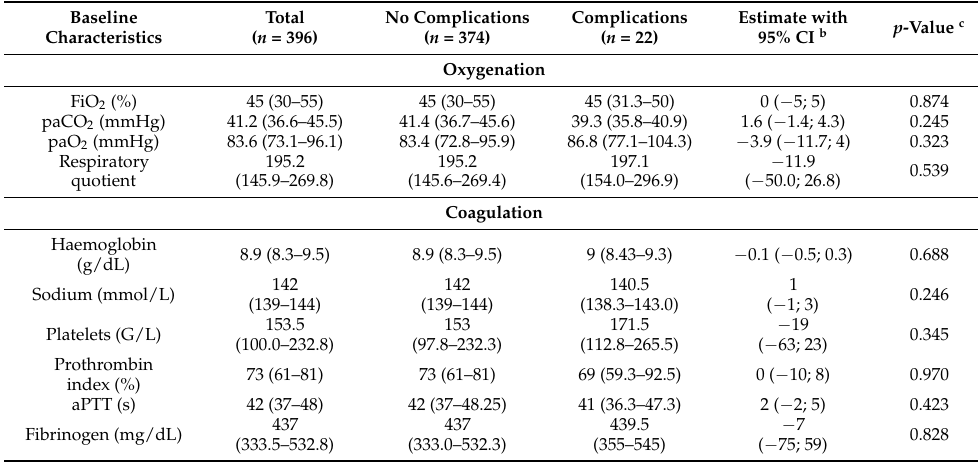
Table 2. Baseline characteristics a per case ( n = 396